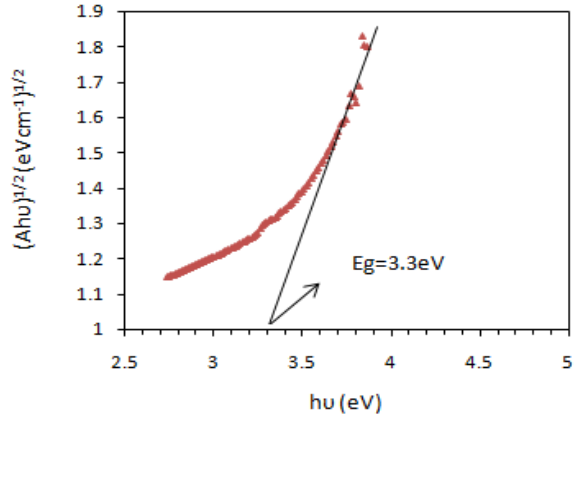
Figure 7. Energy band gap of nanocrystalline tin oxide thin film at the optimum